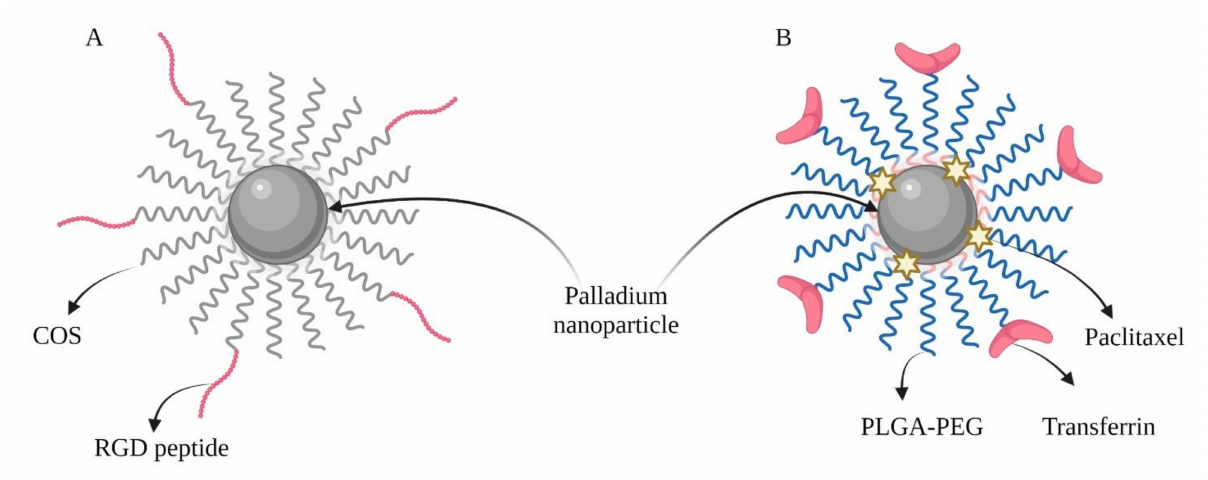
Figure 3. Combined nanoparticles: ( A ) Pd@COS-RGD; ( B ) PdNP/PTX-loaded PLGA-PEG NPs. (created using BioRender.com, access date: 6 May